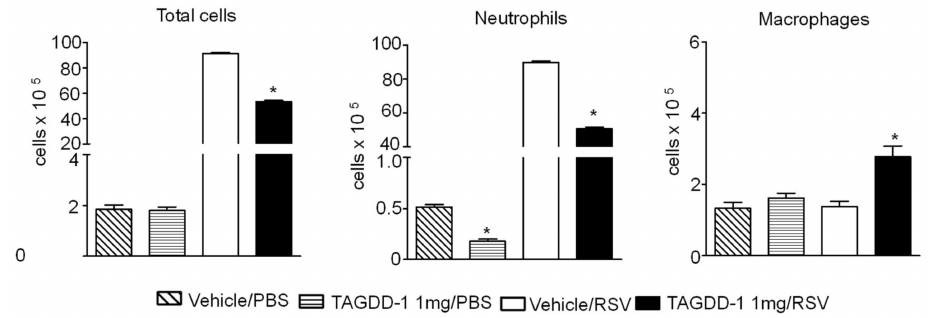
Figure 4. TAGDD-1 reduces airway cellular infiltration after RSV infection. Mice were treated i.n. with TAGDD-1 (1 mg/kg body weight) or an appropriate volume of vehicle (DMSO) 1 h before, 6 h and 20 h after infection with RSV. Bronchoalveolar lavage fluid (BAL) was collected at 1 day p.i. to determine differential cell counts (neutrophils and macrophages) by analysis of Protocol HEMA3 stained cytospins. Data are expressed as mean ± SEM ( n = 4–5 mice/group). * p < 0.05, compared to vehicle/PBS or vehicle/RSV group using one-way ANOVA with Tukey post-hoc